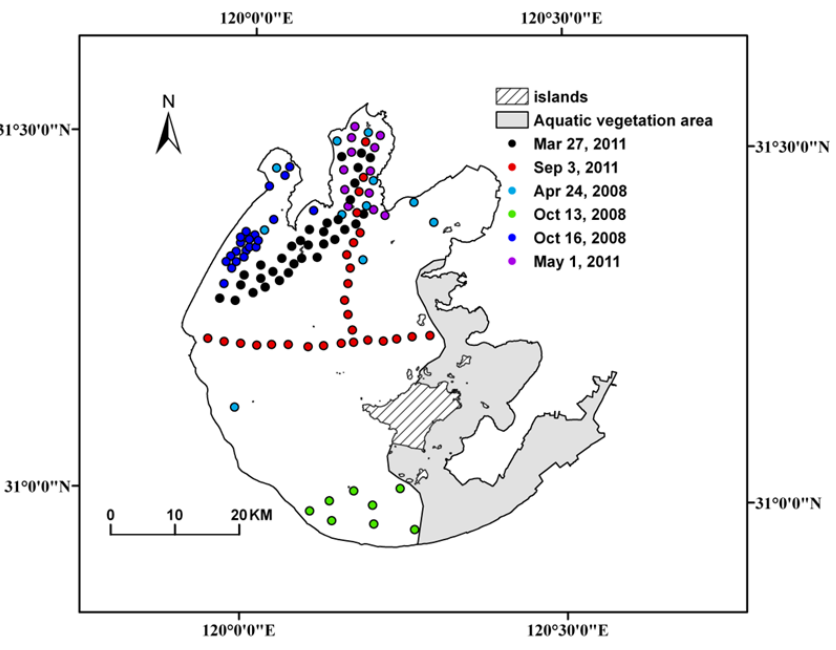
Figure 2. Distribution of sample stations in Lake